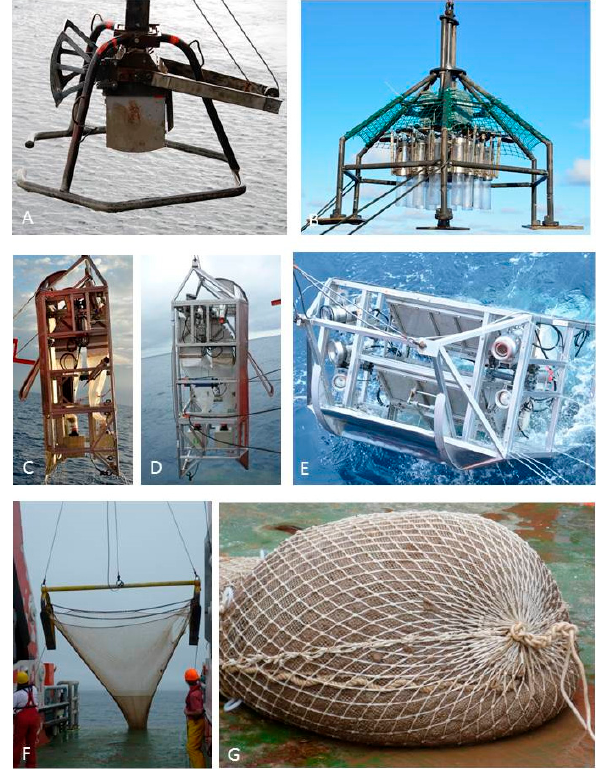
Figure 1. Wire ‐ dependent systems, biological deep ‐ sea gear. ( A ) Box Corer (BC); ( B ) Multiple Corer Figure 1. Wire-dependent systems, biological deep-sea gear. ( A ) Box Corer (BC); ( B ) Multiple Corer (MUC); ( C to E ) Camera ‐ Epibenthic Sledge (C ‐ EBS); ( F ) Agassiz Trawl (AGT); ( G ) cod end of AGT. (MUC); ( C to E ) Camera-Epibenthic Sledge (C-EBS); ( F ) Agassiz Trawl (AGT); ( G ) cod end of